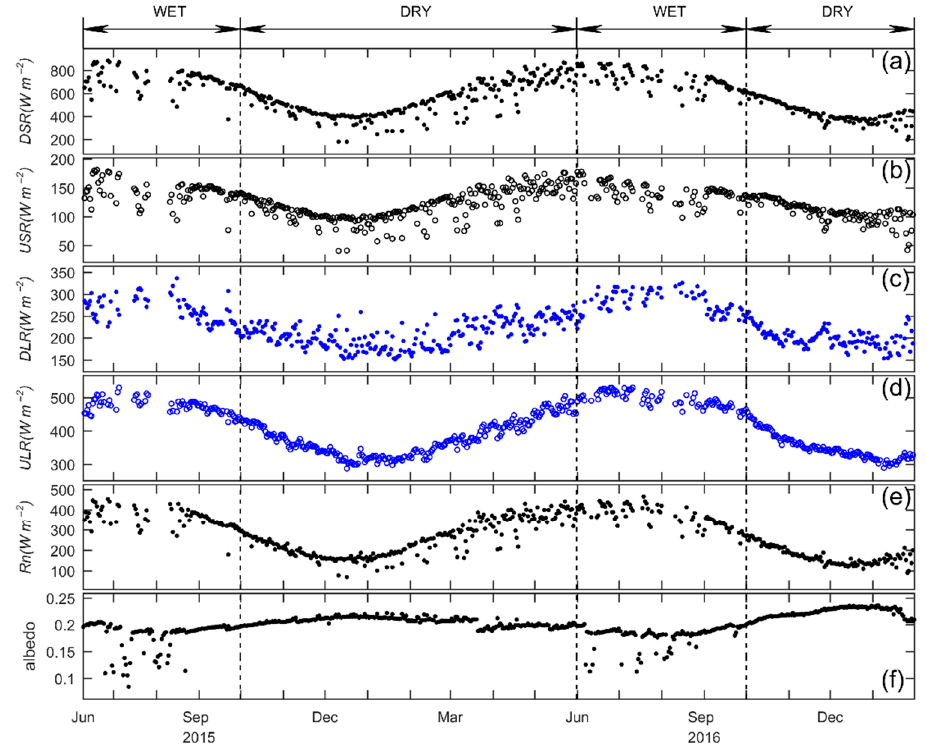
Figure 5. Daily daytime (10:00–19:00 local time) means of ( a ) downward shortwave radiation ( DSR in W m − 2 ), ( b ) upward shortwave radiation ( USR in W m − 2 ), ( c ) downward longwave radiation ( DLR in W m − 2 ), ( d ) upward longwave radiation ( ULR in W m − 2 ), ( e ) net radiation ( Rn in W m − 2 ) and ( f ) surface albedo during the observation period from June 2015 to January 2017 at the Shiquanhe